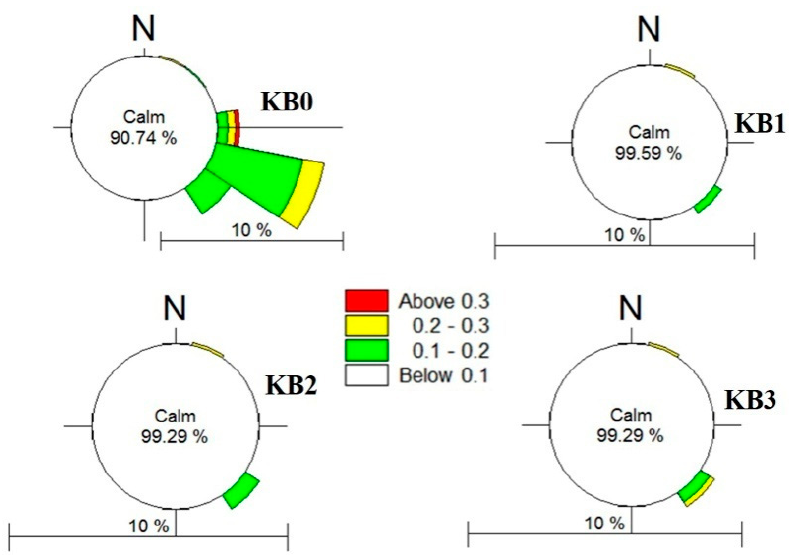
Figure 14. Wave rises by MIKE21 at P5 for KB0, KB1, KB2, and KB3 scenarios in the SW monsoon (September 2014).